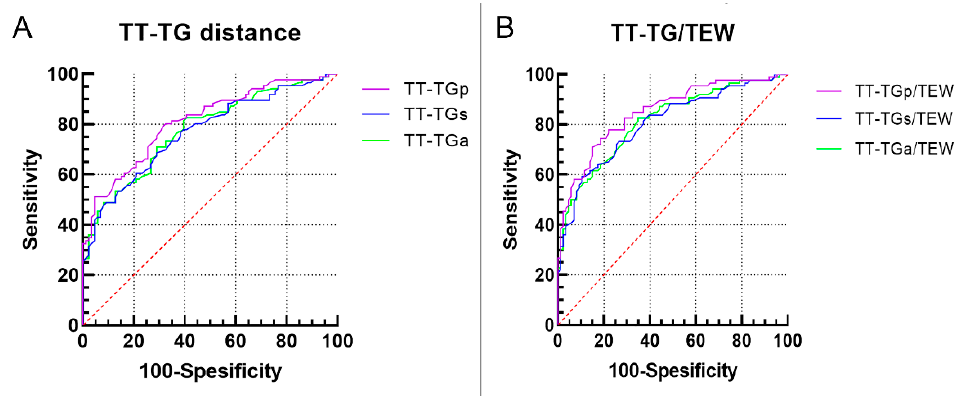
Figure 5. Receiver operating characteristic curves of each tibial tubercle–trochlear groove (TT-TG) distance ( A ) and the three ratios of TT-TG distances/TEW ( B ). TEW, surgical transepicondylar width. Table 4. Sensitivity and Specificity of the Cutoff Values.